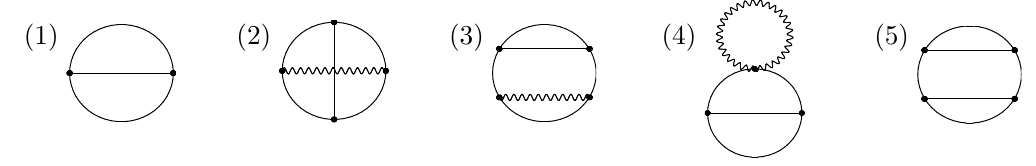
Figure 1 . Supergraphs generating the contributions to the (cid:12) -function containing the Yukawa couplings in the three-loop